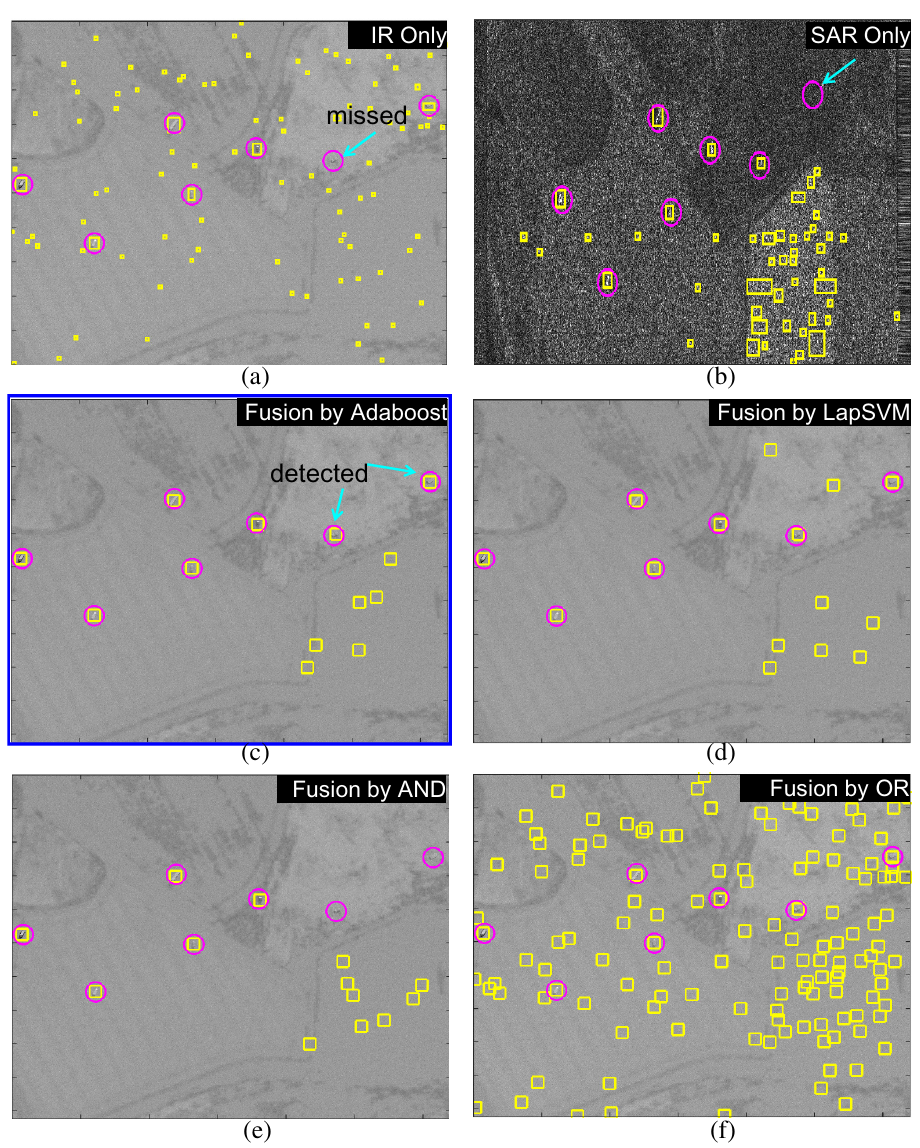
Figure 29. Comparison of target detection on the BG2-T7-IR/SAR DB: ( a ) without fusion (IR only); ( b ) without fusion (SAR only); ( c ) proposed Adaboost-based fusion; ( d ) LapSVM-based fusion; ( e ) logical AND fusion; and ( f ) logical OR